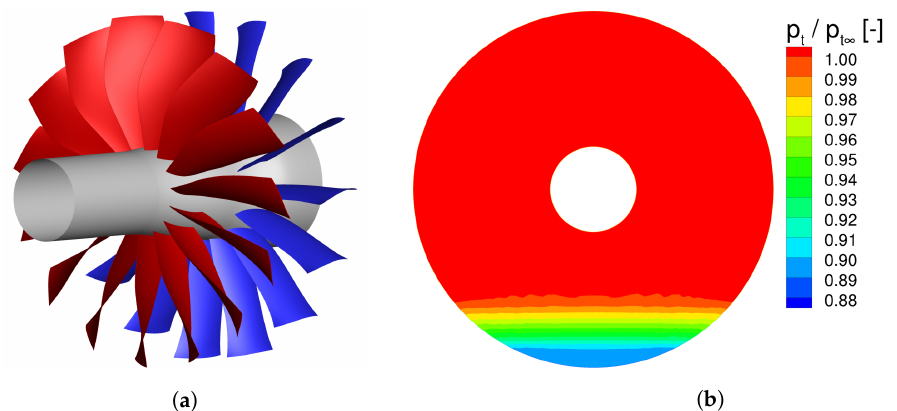
Figure 5. Full annulus setup of the fan stage ( a ) and distorted relative total pressure distribution on fan stage inlet plane ( a